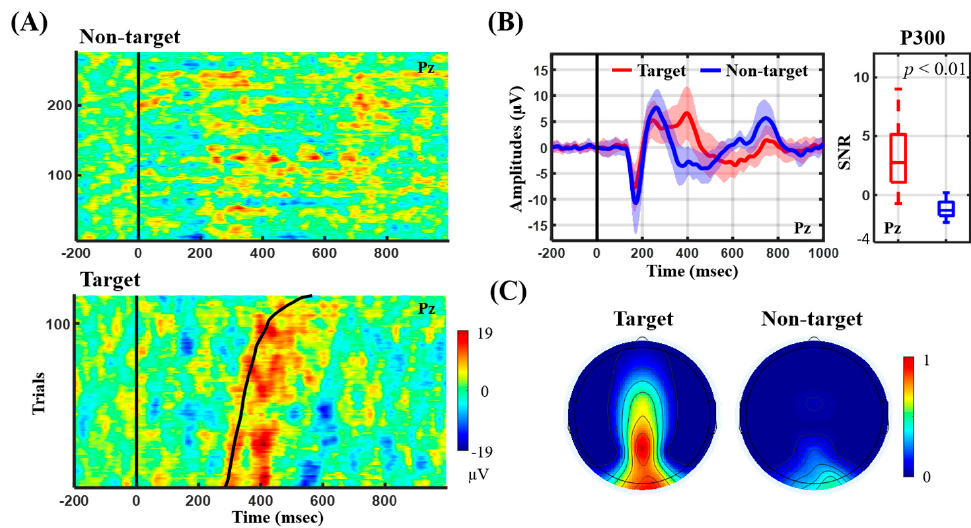
Figure 3. The ERP outcomes recorded in an auditory oddball ERP paradigm. ( A ) ERP images of Pz from a representative subject; ( B ) ERP profiles and P300 SNR (i.e., 300–500 ms) of Pz summarized by 15 participants; ( C ) averaged topographic mapping of P300 SNR using the adopted eight electrodes.